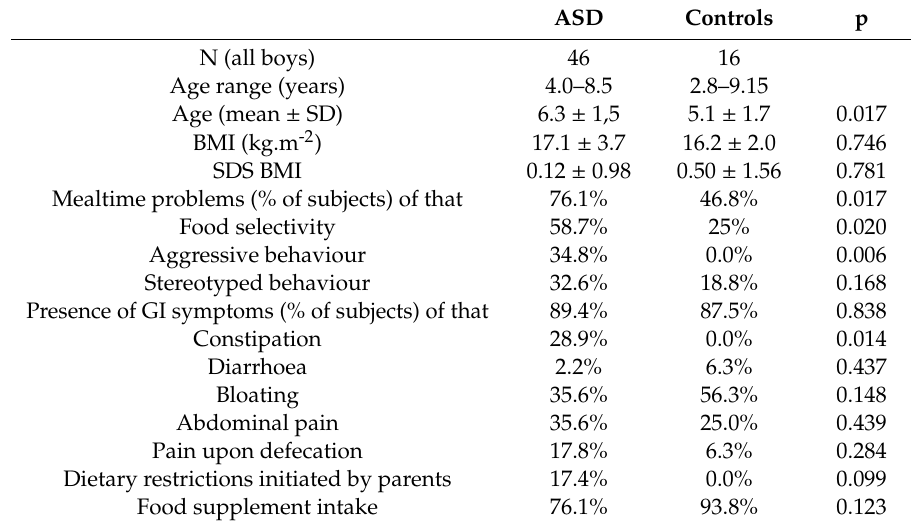
Table 1. Gastrointestinal symptoms and nutrition-related characteristics of cohorts of individuals with autism spectrum disorder (ASD) and neurotypical controls. ASD Controls